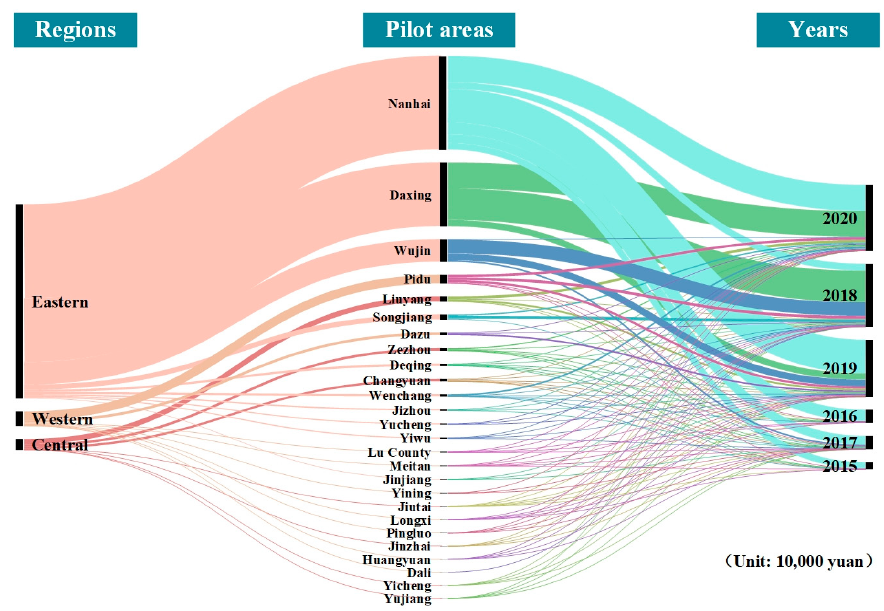
Figure 3. Transaction values of CCCL.